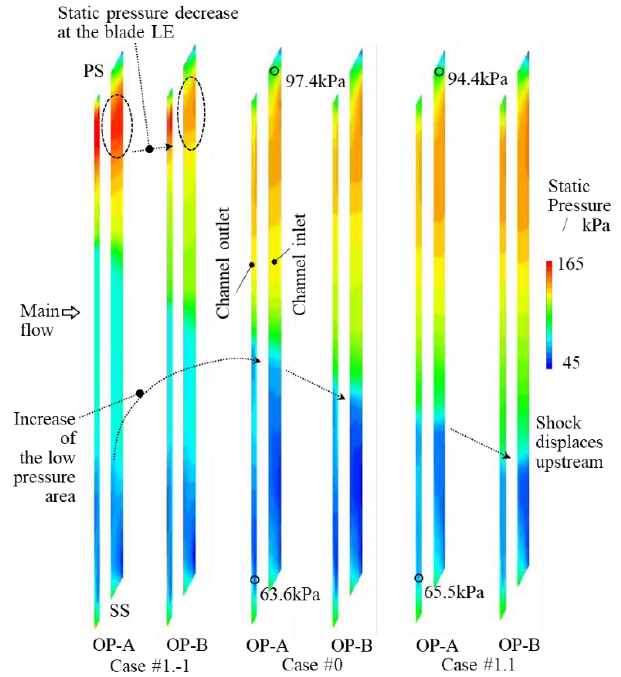
Figure 9. Distributions of the static pressure across the RC openings. View from above the casing, approximately in the cascade plane.